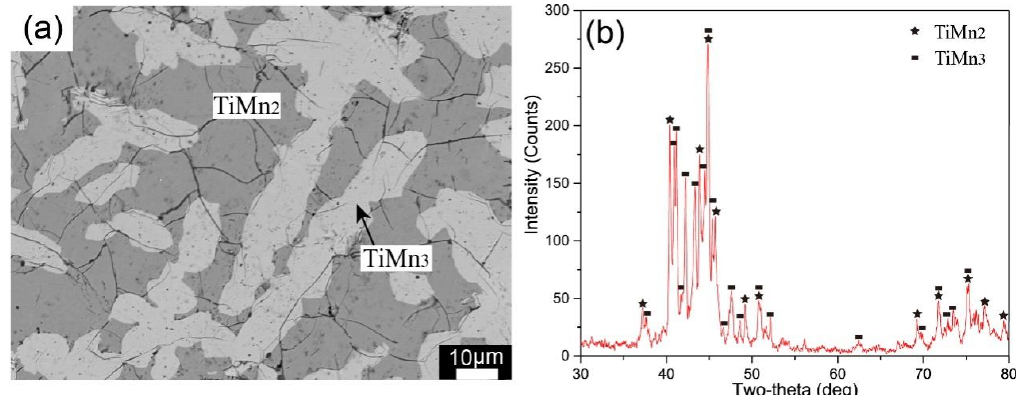
Figure 19. Alloy B10 annealed at 1273K for 60 days: ( a ) BSE images, ( b ) XRD patterns.